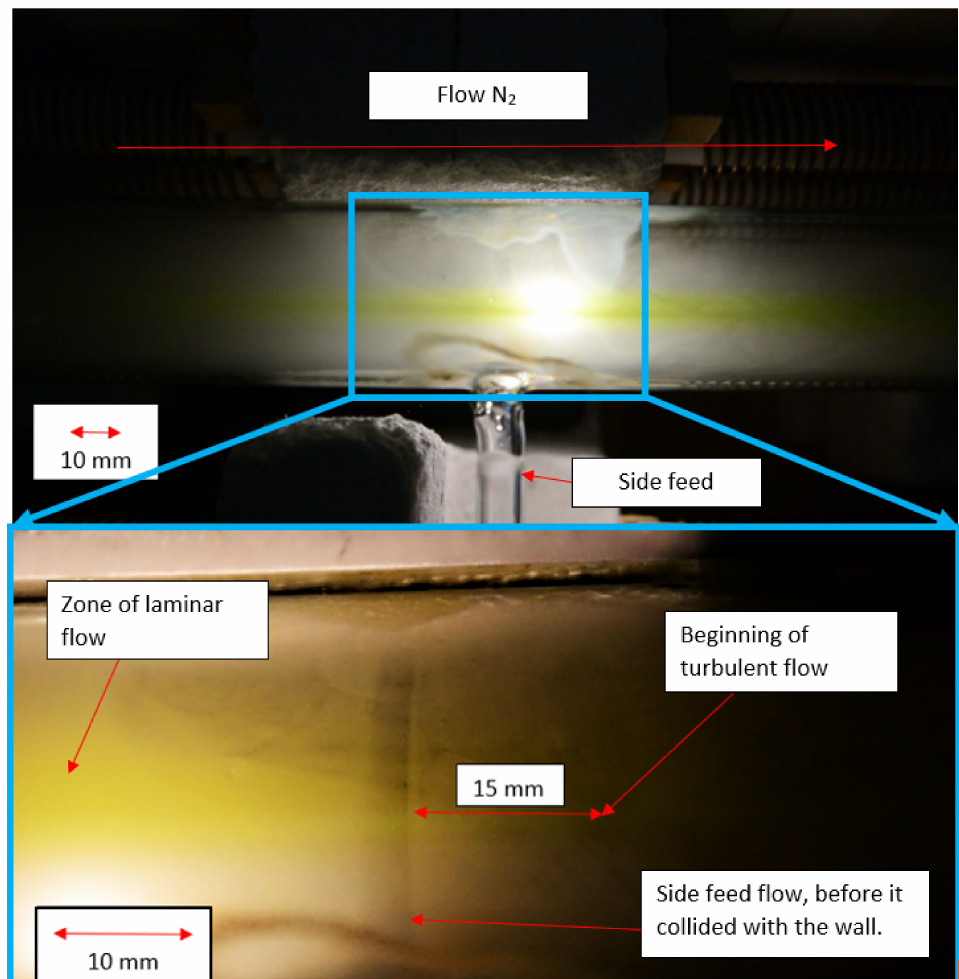
Figure 12. Experimental testing—a snapshot of H 2 (5 L/min) entering the aerosol carried by N 2 (10 L/min) in the USP device.